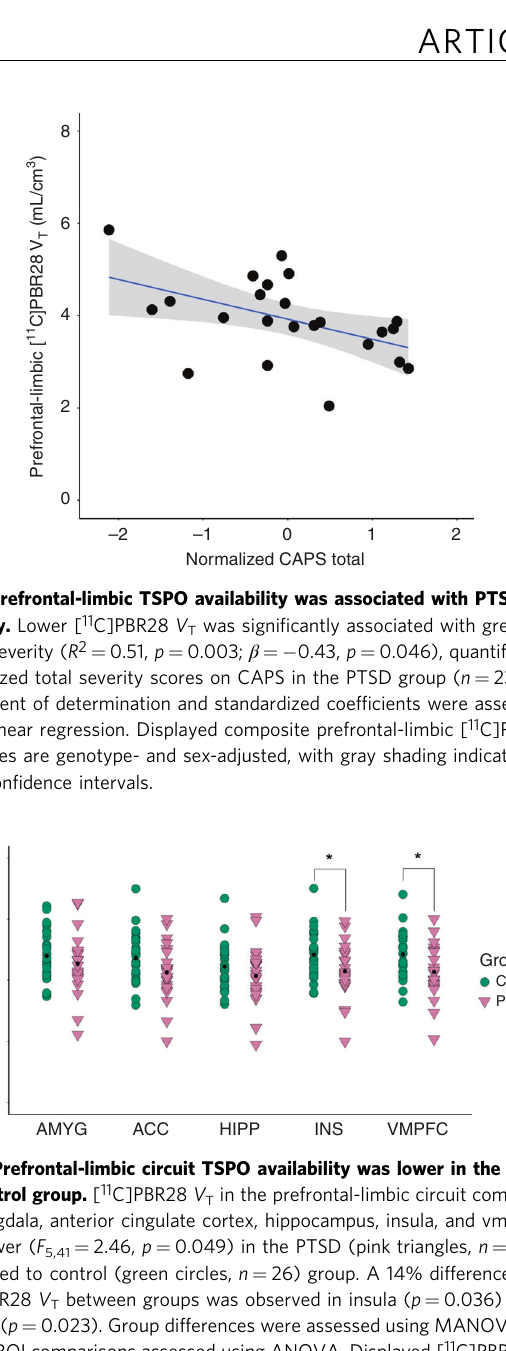
[ 11 C]PBR28 V T was signi fi cantly lower in the PTSD than the control group (Fig. 2: MANOVA: F 5,41 = 2.46, p = 0.049), reaching regional signi fi cance in the insula (14% lower, p = 0.036) and vmPFC (14% lower, p = 0.023). Sensitivity analyses showed that the overall PTSD vs. control group difference in prefrontal-limbic TSPO availability remained signi fi cant after adjusting for tobacco, cannabis, and alcohol use (all F > 2.47, all p < 0.05). There were no differences in prefrontal- limbic TSPO availability between individuals in the PTSD group with or without comorbid MDD ( p = 0.60) or current psycho- tropic medication use ( p = 0.59), and between individuals in the control group with or without trauma exposure ( p = 0.85).